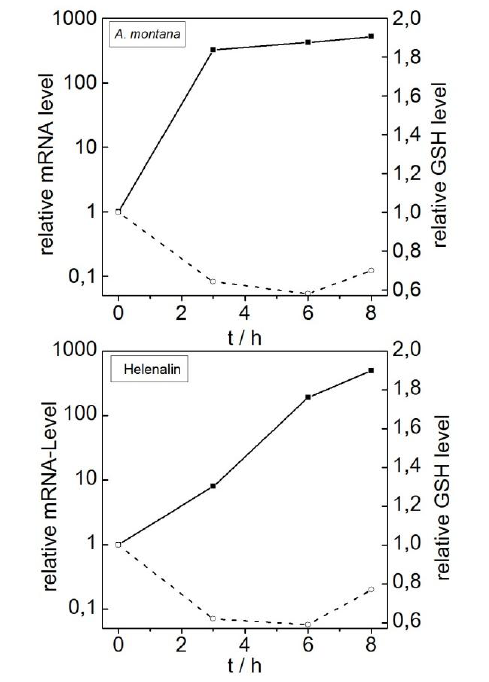
Figure 3. Responses of HaCaT cells to treatments with Arnica montana extract and helenalin. HSP70B’ expression (detected by qRT-PCR) and changes in tGSH levels were measured following the incubation of HaCaT cells with 125 µg/mL A. montana or 5 µM helenalin. Solid lines represent the detection of the relative mRNA levels of HSP70B’ compared with untreated cells. Dashed lines represent the relative tGSH levels. For each panel, average values from 3–6 independent experiments are